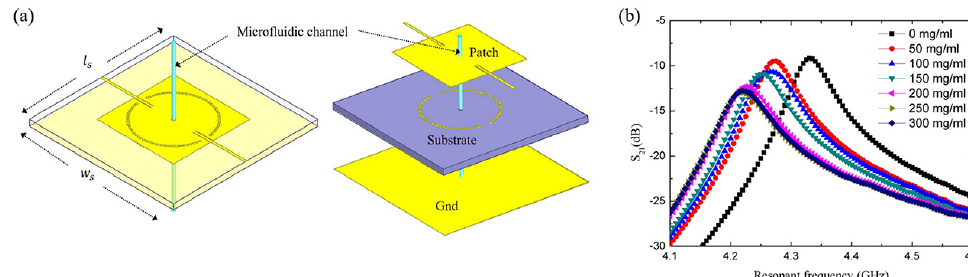
Figure 8. Glucose concentration detection using a TM 010 mode circular SIW with a microfluidic subsystem. ( a ) Configuration of the sensor. ( b ) Variation in the transmission coefficient with the glucose concentration